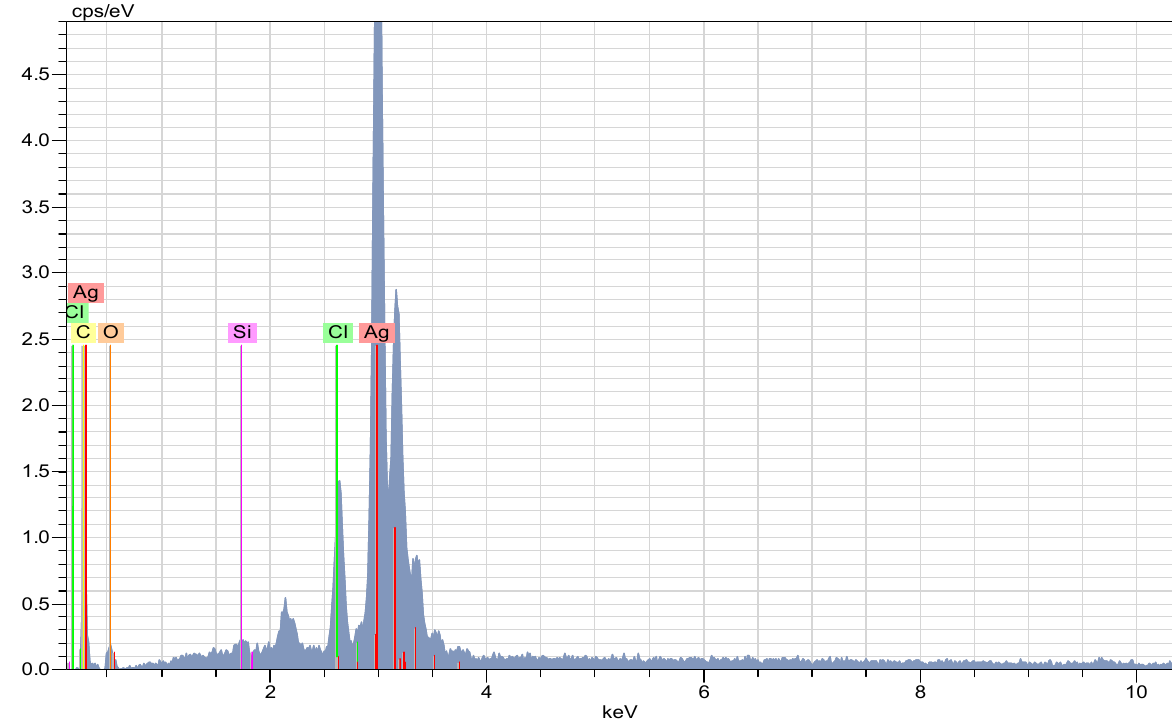
Figure 5. EDX spectrum demonstrating the presence of silver in AC-AgNPs.